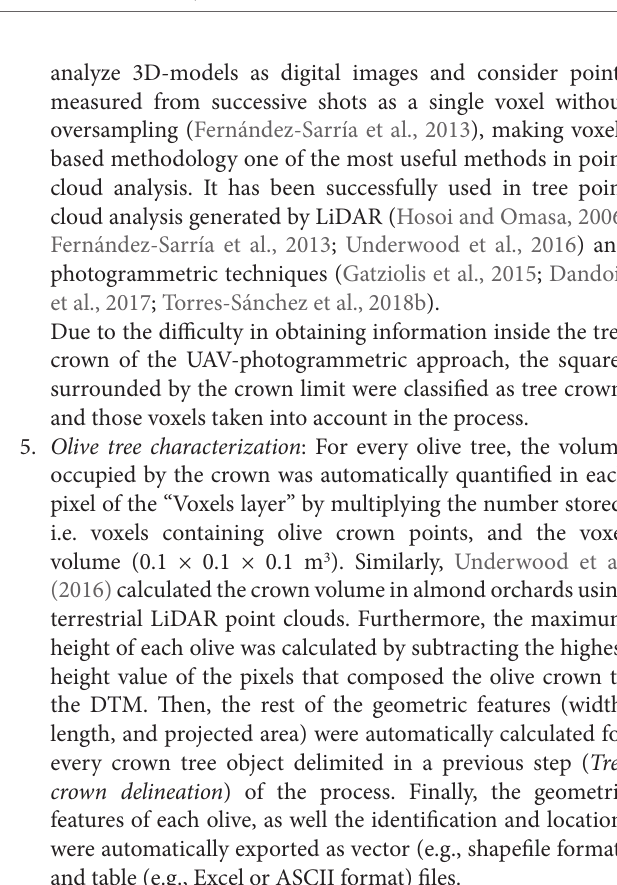
Frontiers in Plant Science |